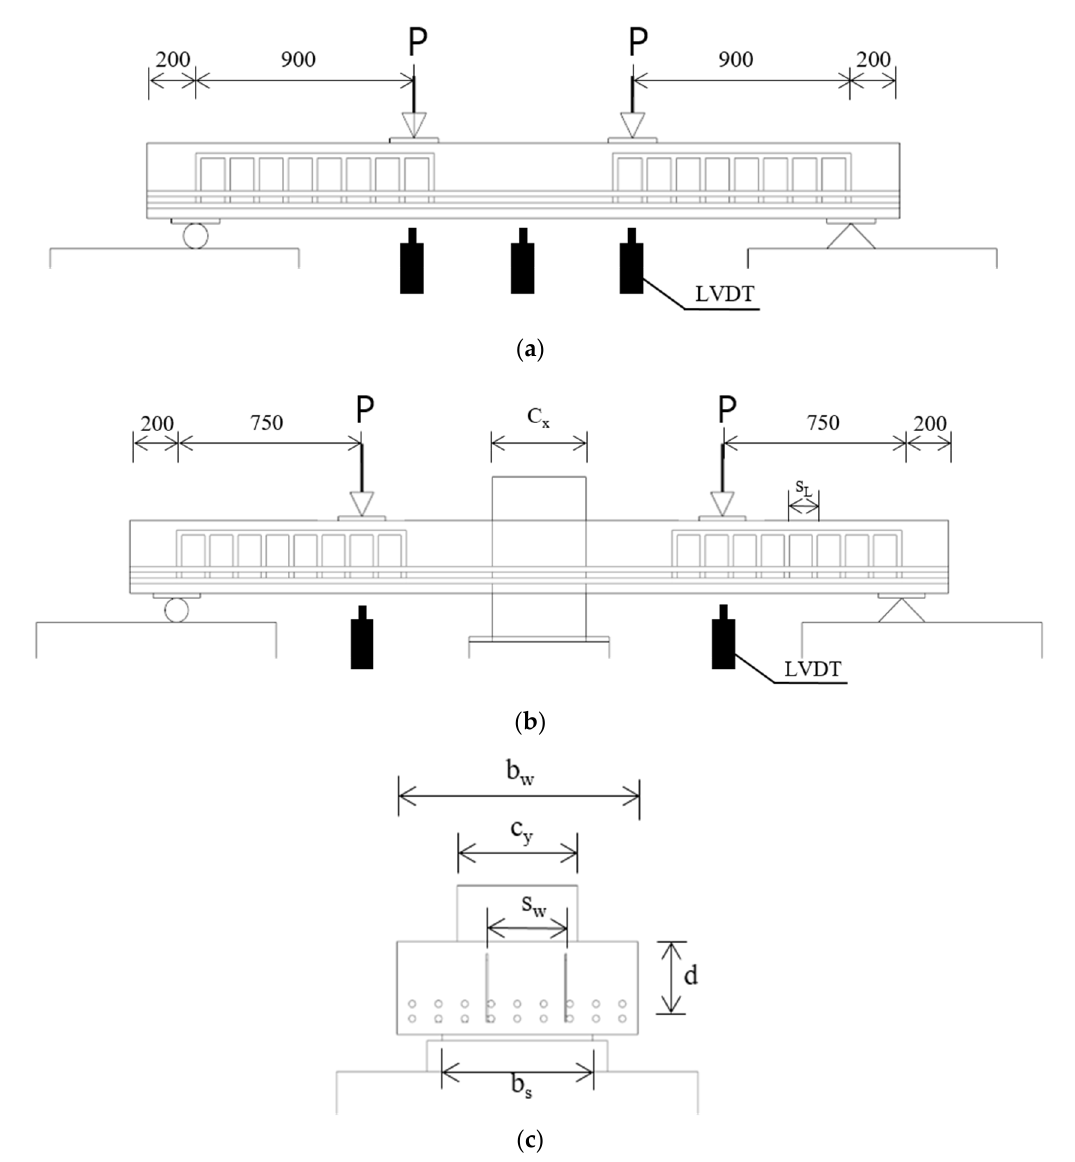
Figure 4. Test setup and dimensions: ( a ) general wide beam (groups A and B); ( b ) wide beam with column (group C1); ( c ) wide beam with different support width (group C2).